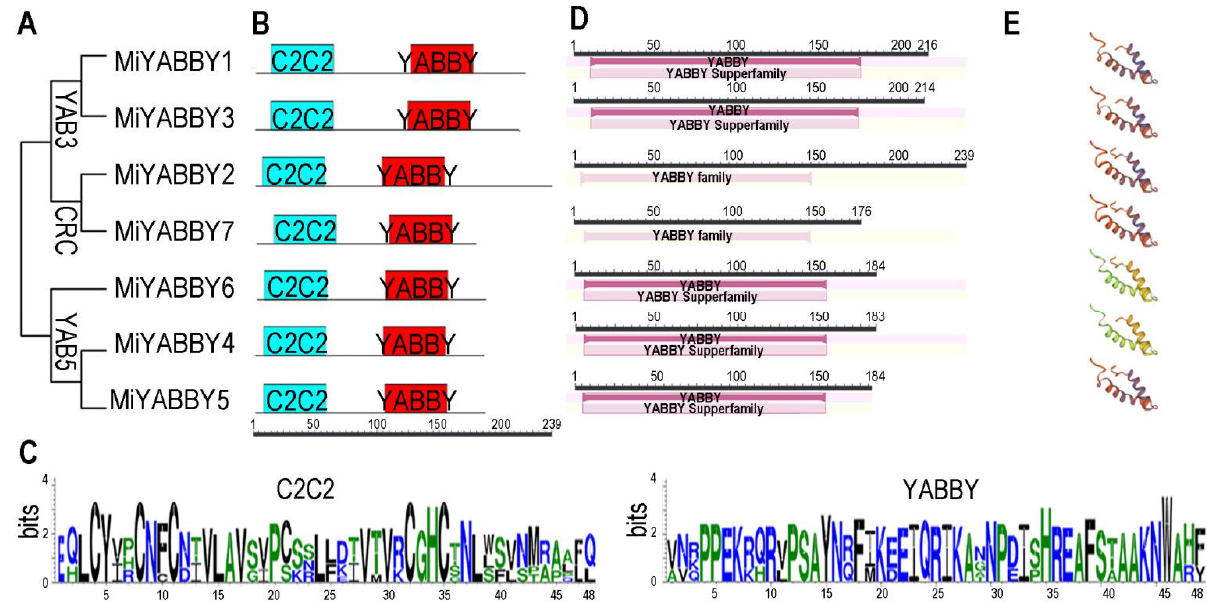
Figure 1. Phylogenetic analysis, conserved domain analysis, inherited superfamily domains, and tertiary structure of proteins in the MiYABBYs family. ( A ) is the phylogenetic tree of the MiYABBY family, and all members were classified into three groups, including YAB3, CRC, and YAB5. ( B ) are the two motifs of MiYABBYs: C2C2 (blue grid) in the N-terminal and YABBY (red grid) in the C-terminal. ( C ) are the sequences of these motifs. ( D ) is the forecast of the superfamily of MiYABBYs in NCBI Blast (CD-search). ( E ) is tertiary structure of the MiYABBYs in SWISS-MODEL software.